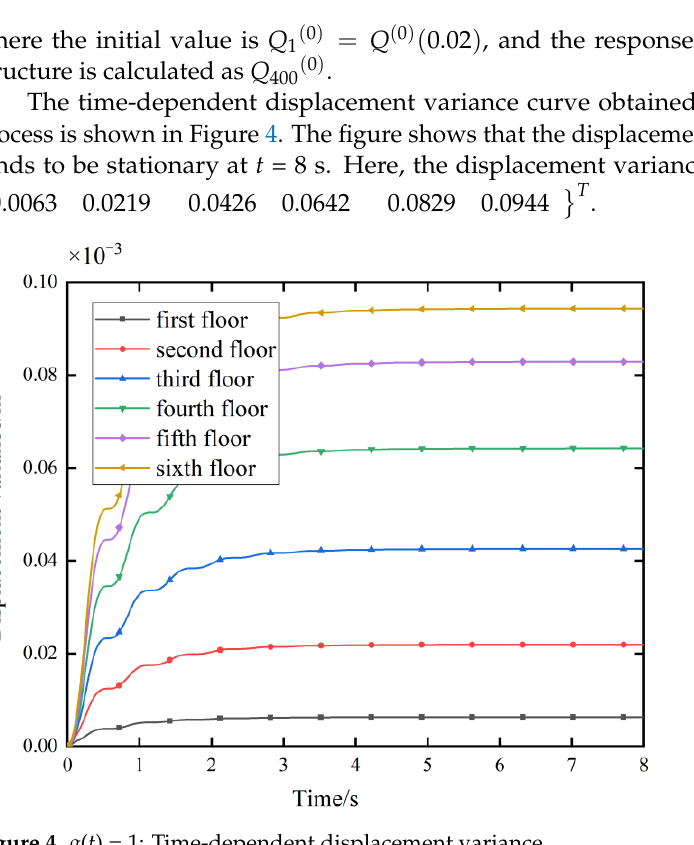
Figure 4. g ( t ) = 1: Time-dependent displacement variance.